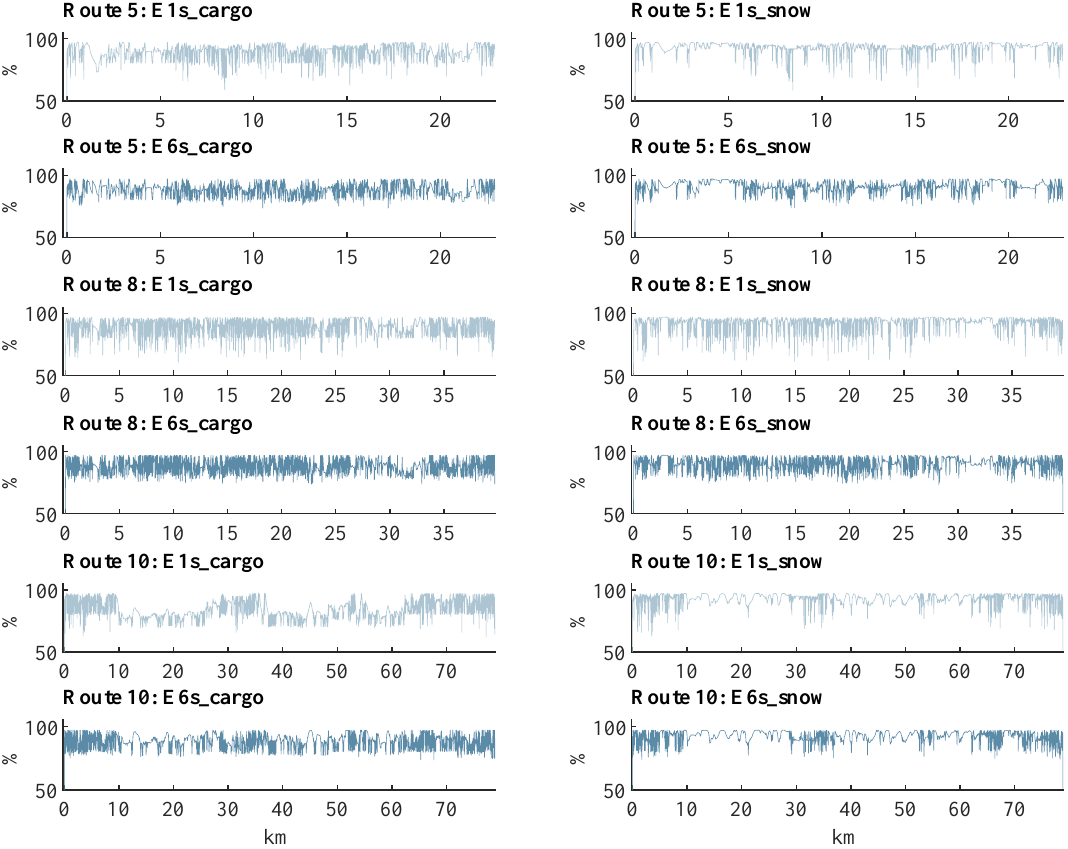
Figure 14. Simulated powertrain efficiency for the electric vehicles throughout driving cycles 5, 8, and 10. The graphs on the left describe the cargo scenarios, whereas the graphs on the right show the snow load